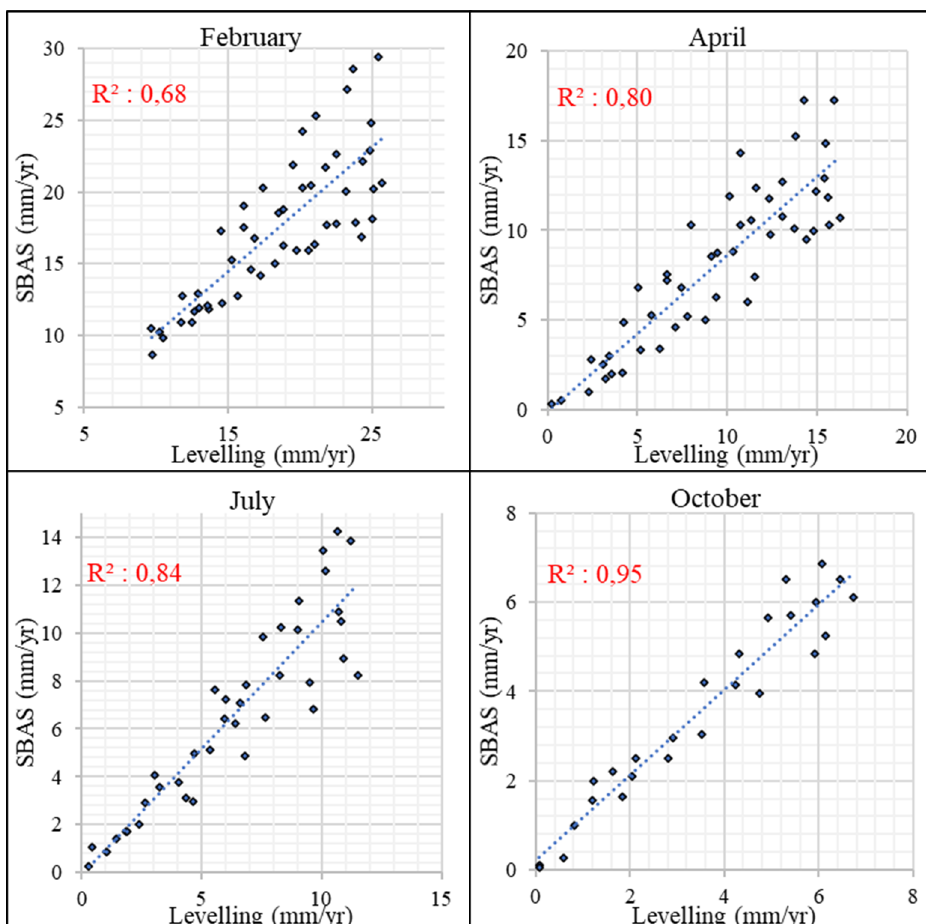
Figure 11. Regression analysis between water levels derived by SBAS that exported vertical units and levelling.